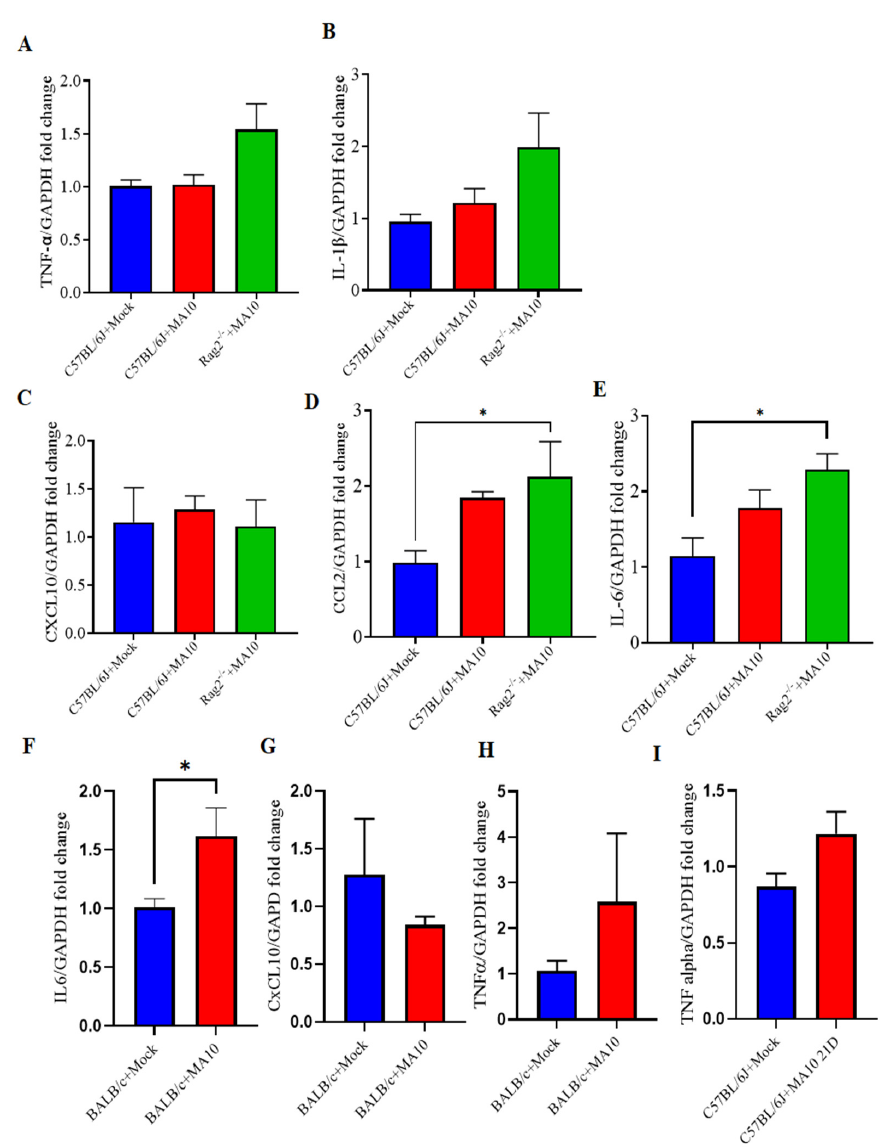
Figure 2. CNS cytokine and chemokine responses in the brains of mouse ‐ adapted SARS ‐ CoV ‐ 2 (MA10) infected laboratory mice . 10 ‐ week ‐ old male C57BL/6, BALB/c and Rag2 − / − mice were inoculated via the intranasal route with mock or MA10 strain of SARS ‐ CoV ‐ 2 (1 × 10 5 TCID 50 ). Upon 3 days post ‐ infection (3 dpi), mice were euthanized, and RNA was isolated from the left hemisphere for gene expression analysis. ( A ) TNF ‐α and ( B ) IL ‐ 1 β mRNA expression in brains of SARS ‐ CoV ‐ 2 (MA10) infected C57BL/6J mice did not significantly differ from those of mock ‐ infected mice. ( C ) Cxcl10 ; ( D ) Ccl2 and ( E ) IL ‐ 6 expression in brains of SARS ‐ CoV ‐ 2 (MA10) infected Rag2 − / − mice and C57BL/6J mock ‐ treated mice. ( F ) IL ‐ 6 ( G ) CxCL10 ( H ) TNF ‐α expression in BALB/c mice. ( I ) 21 days post ‐ infection (21 dpi), male mice were euthanized and analyzed for TNF ‐α mRNA expression in C57BL/6 mice, SARS ‐ CoV ‐ 2 MA10 infected C57BL/6 mice show a trend towards increased TNF ‐α expression compared to mock ‐ treated mice. IL ‐ 6 was significantly increased, and TNF ‐α showed an upward trend in SARS ‐ CoV ‐ 2 MA10 ‐ infected BALB/c mice compared with mock ‐ treated mice. Data are presented as mean ± SEM. p values represent mock vs SARS ‐ CoV ‐ 2 (MA10) challenged groups. Significant differences are designated using a two ‐ tailed unpaired student t ‐ test for two groups and one ‐ way ANOVA (for more than two groups). Some of the experiment n = 4 indicates 2 mice were excluded because the dissection of half left hemisphere did not align with other mice. C57BL/6J +